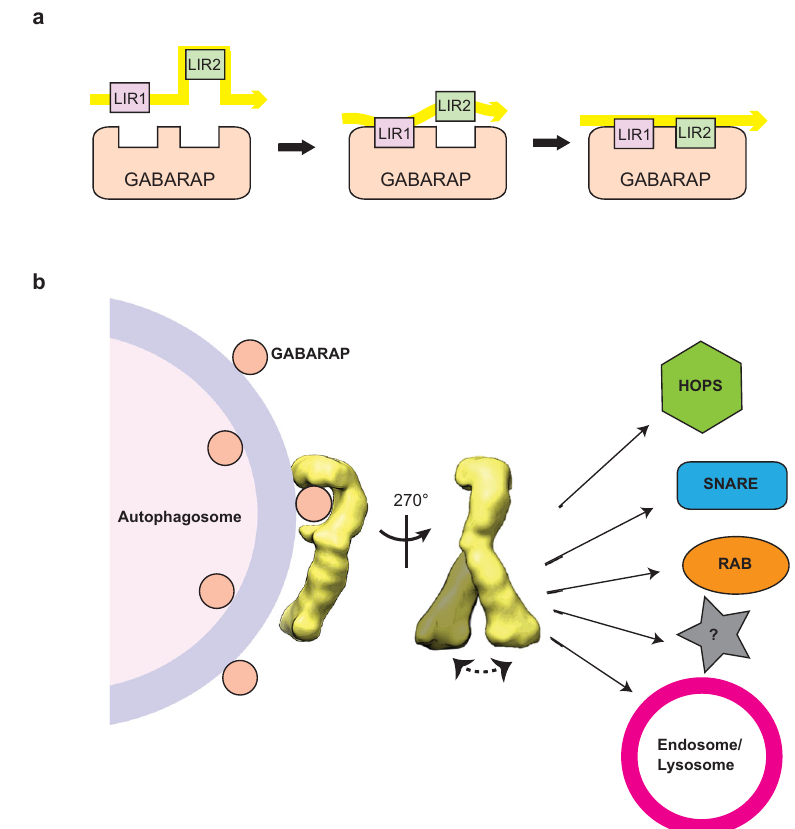
Fig. 7 Proposed model of hEGP5-mediated tethering in the terminal stage of autophagy. a Schematic diagram of the hEPG5 tandem LIR motifs binding to GABARAP subfamily in a “ two-factor authentication ” step-wise binding model. LIR1 is recognized by GABARAP possibly at a noncanonical site initially, with subsequent local conformational change allowing LIR2 becomes accessible to binding at the canonical site on GABARAP. b hEPG5 interacts with autophagosome by binding to GABARAP on the concave side of its hook. The convex side of the hook and the fl exible stalk may interact with HOPS complex, SNARE proteins, RAB proteins, as well as the late endosome and lysosome to facilitate autophagosome – lysosome